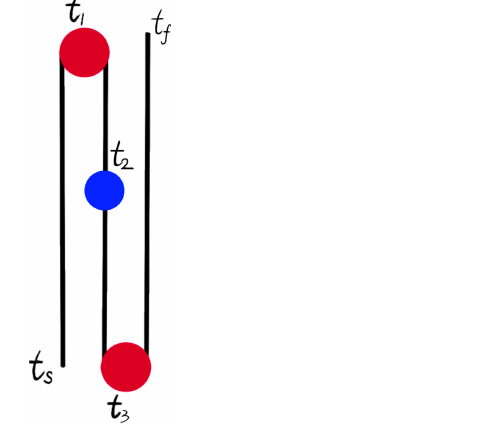
Figure 3 . Time-fold with three insertions. The insertions at t 1 , t 3 occur at the switchback points. The insertion at t 2 occurs at the through-going